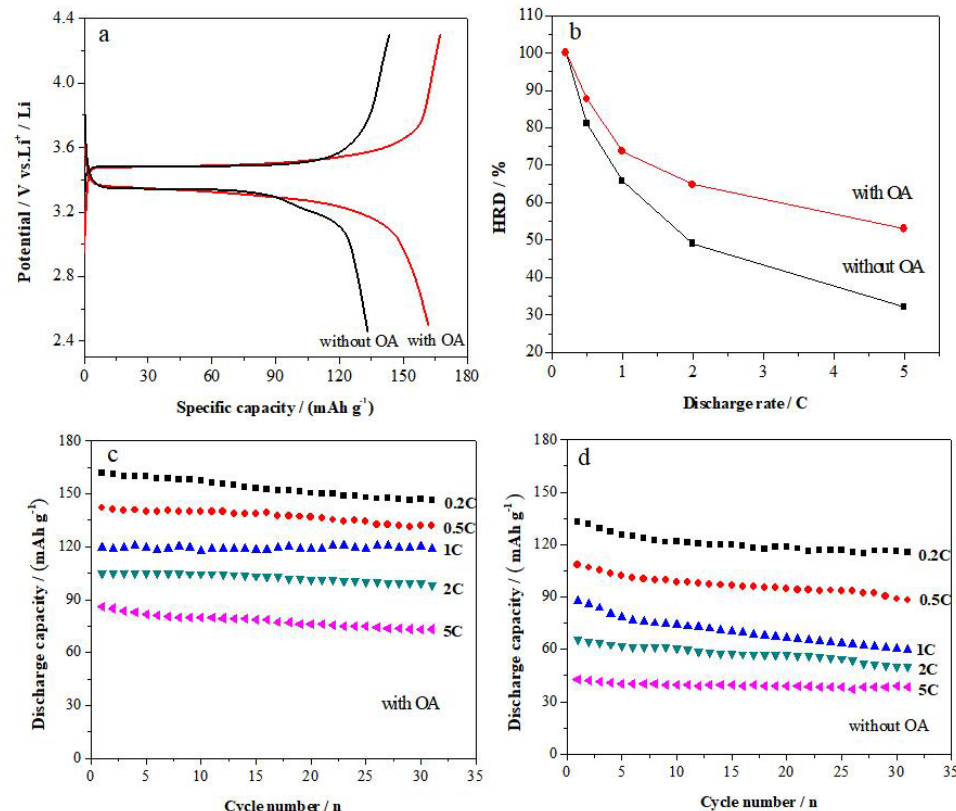
Figure 4. Initial charge/discharge profiles ( a ), the HRD ( b ), cycle performance of LiFePO 4 electrodes prepared with OA ( c ) and without OA ( d ).